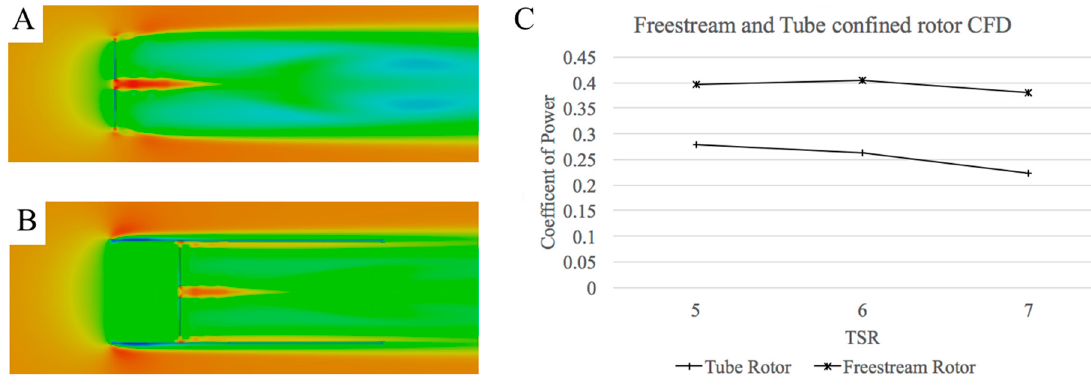
Figure 8. Turbines in ( A ) free stream and ( B ) tube; ( C ) power vs. TSR for each case.